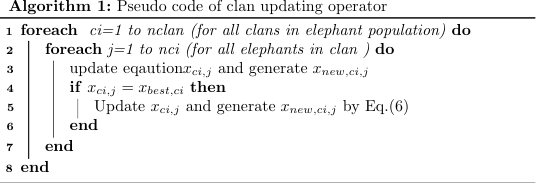
Algorithm 1: Pseudo code of clan updating operator